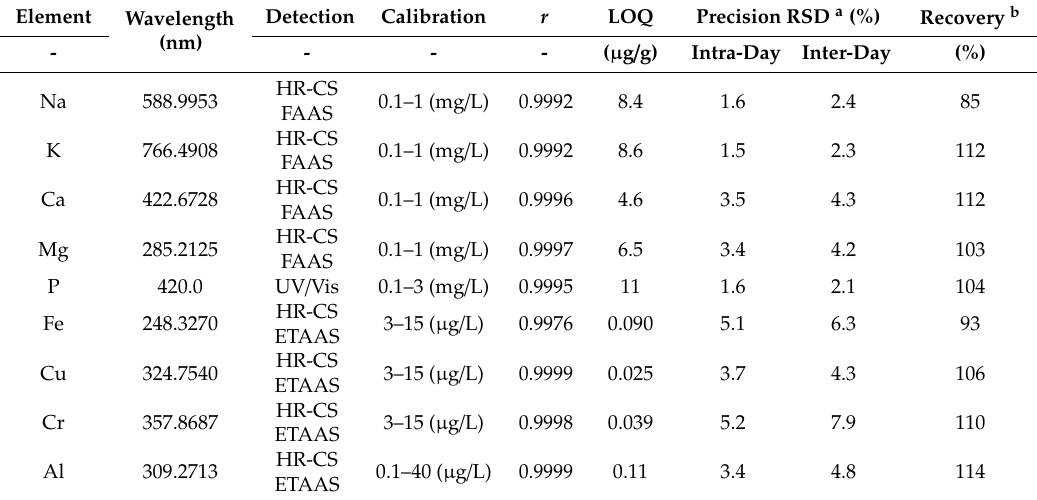
Table 2. Methods validation parameters: linear range and correlation coe ffi cients ( r ) of the analytical calibration curves, intra- and inter-day precisions (RSD, %), and limits of quantification (LOQ) for the elements studied.